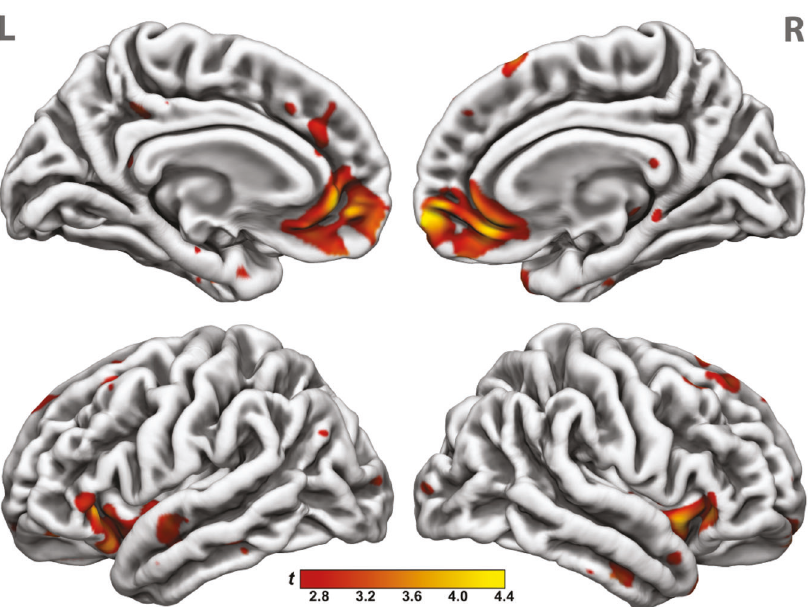
FWE familywise error. a Threshold set at P